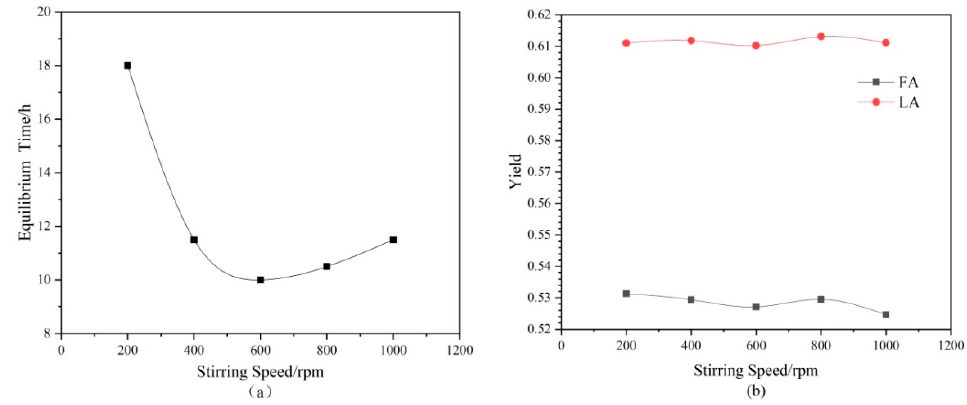
Figure 6. Effect of stirring speed on the yields of ( a ) LA and ( b )